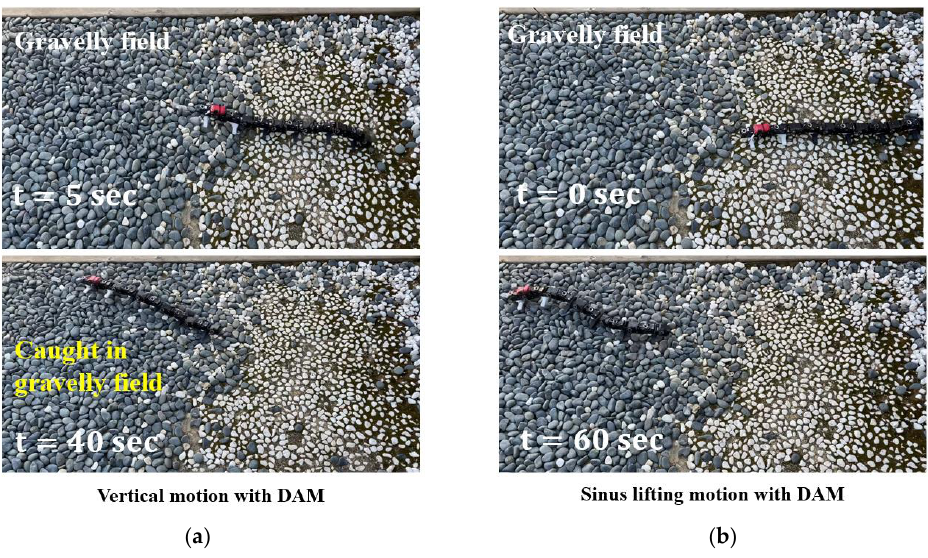
Figure 26. Performance of the robustness with the DAM on the gravelly field. ( a ) The vertical motion with DAM in the gravelly field. ( b ) The sinus lifting motion with DAM in the gravelly field.